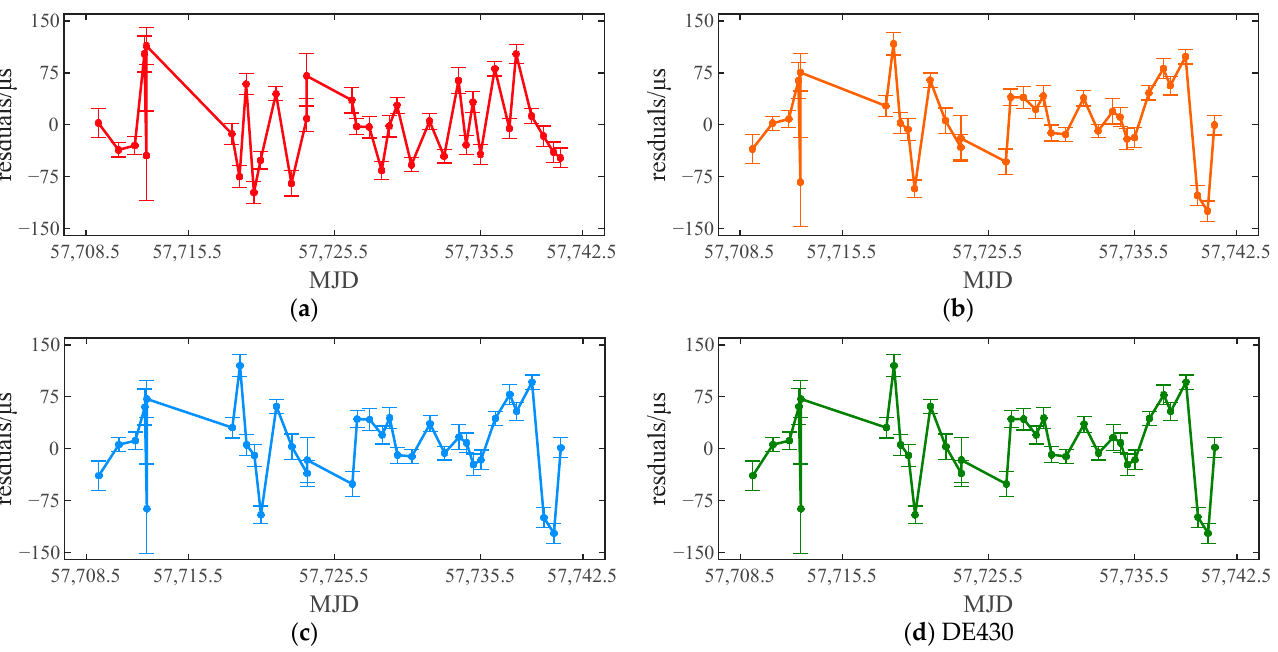
Table 3. Pearson correlation coefficient between pulse profiles. P_200_405 represents the Pearson correlation coefficient between DE200 profile and DE405 profile, and the rest are analogous.